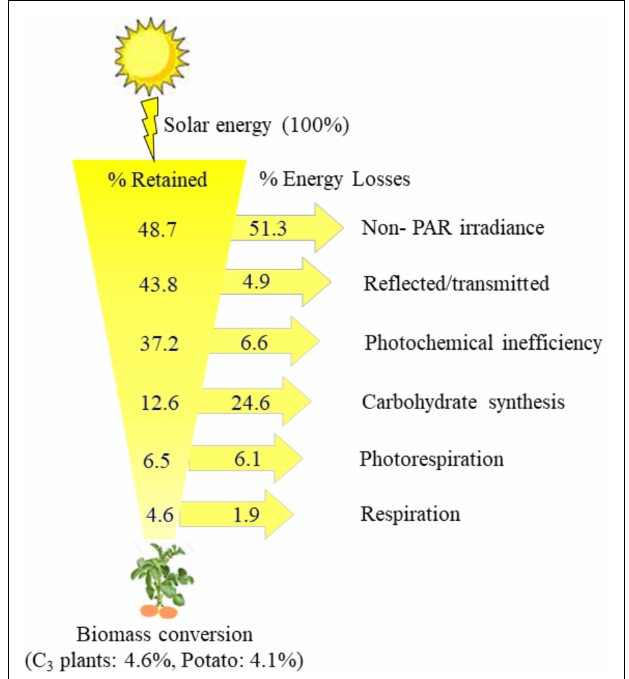
FIGURE 2 | A simplified model for the processes involved in the conversion of solar incident energy to final plant biomass and associated energy losses. Out of 100% solar incident energy the C 3 photosynthetic organisms are capable of converting only 4.6% to final plant biomass, suggesting a maximum theoretical energy conversion efficiency of 0.046. Most portion of solar energy is lost resulting in considerable decrease in energy conversion efficiency between the solar energy and final plant biomass. Redrawn from Zhu et al. (2008, 2010); and modified based on Dahal et al.